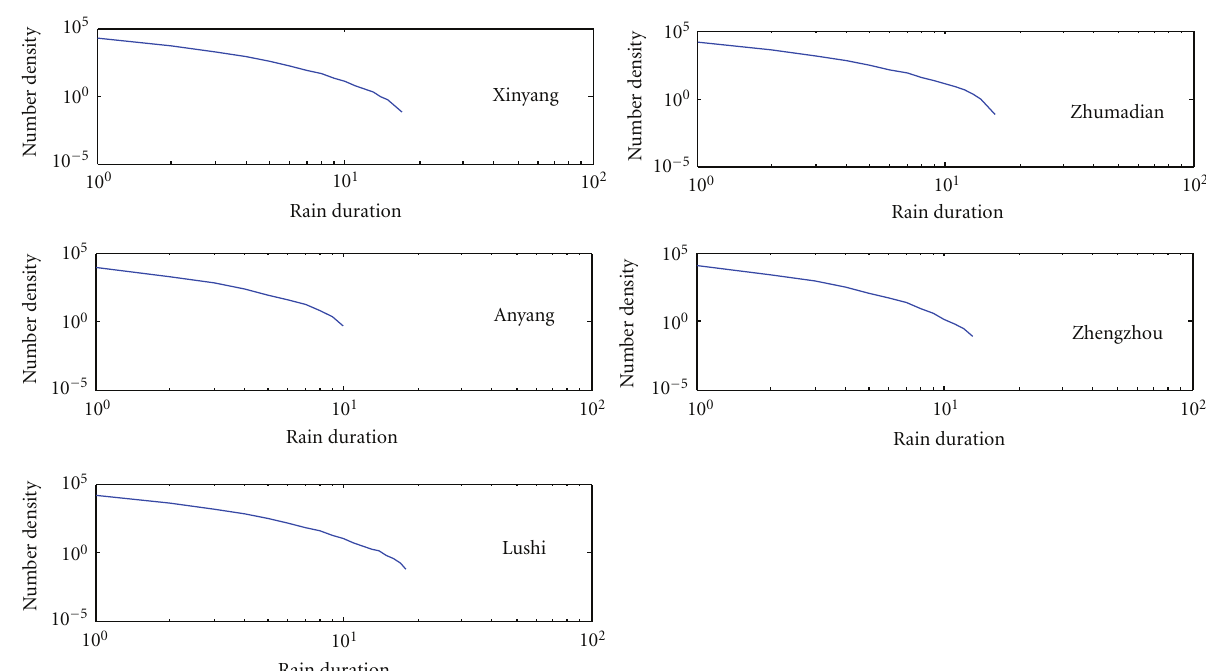
Figure 3: Log-log plot of the probability number density for rain